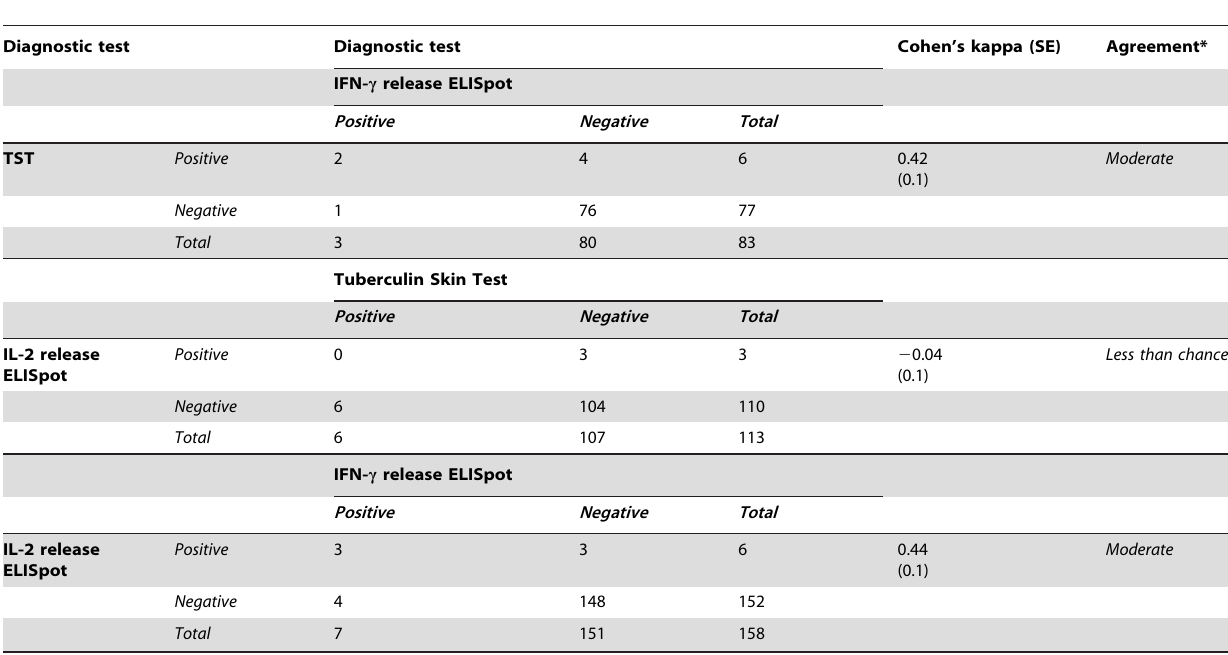
*Criteria based on the interpretation of Landis and Koch are used. doi:10.1371/journal.pone.0011670.t003 PLoS ONE |